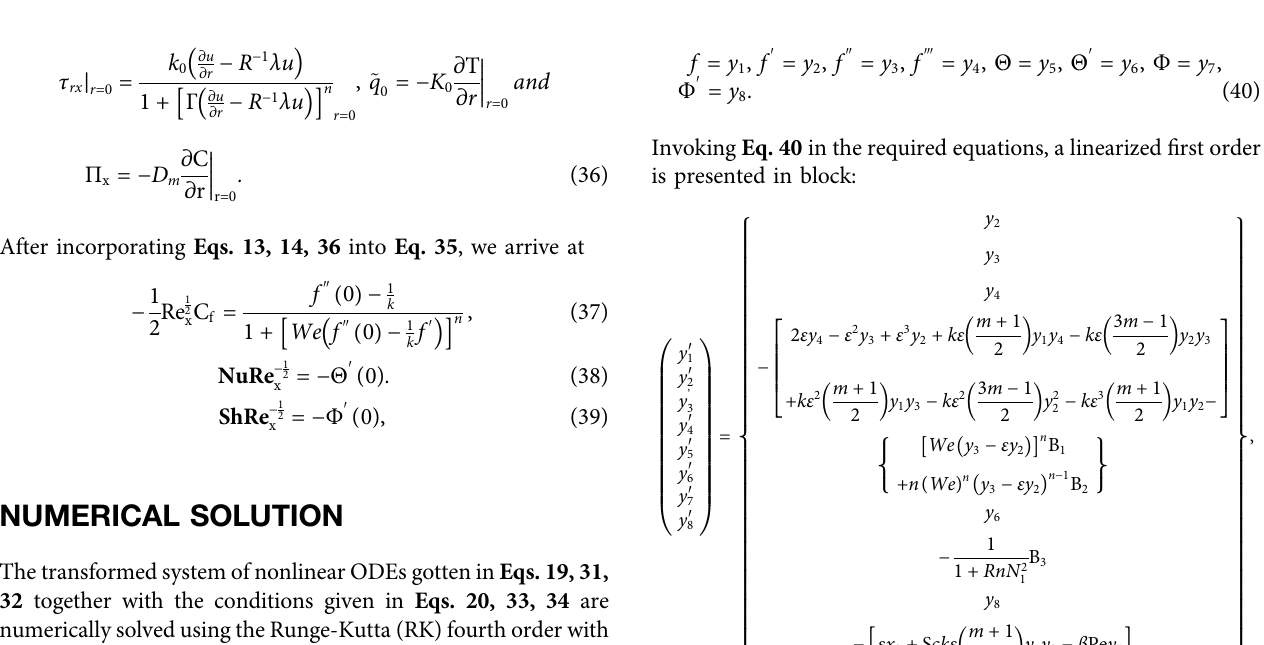
FIGURE 5 | Effect of Pr, Ec, Rn, and w on